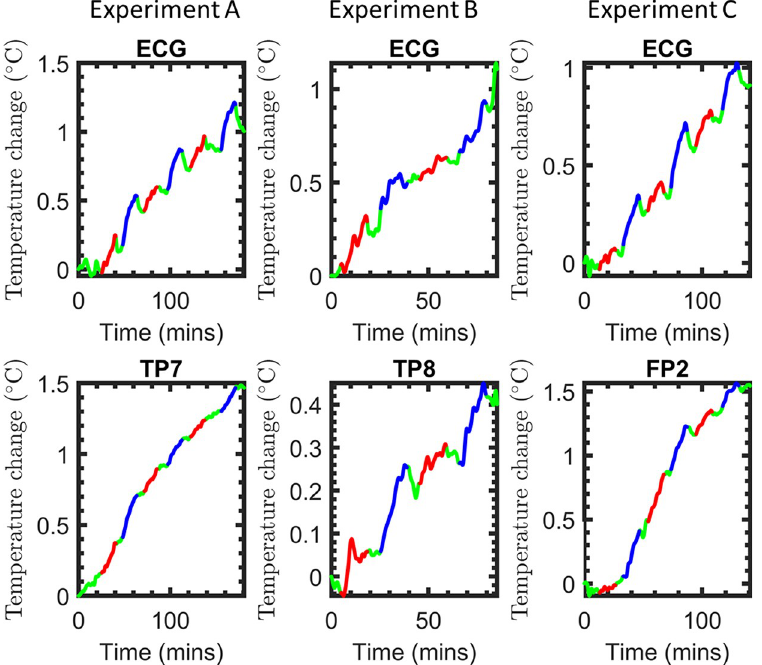
Fig 2. Temperature measurements in the watermelon “phantom”. The total course of consecutive measurements during the different conditions are color coded for the MB sequence (red), the SB sequence (blue), and rest periods of no scanning (green). The ECG electrode, which has the longest lead and highest potential of heating, was included in all three experiments A through C. Experiments A, B, and C additionally measured temperature at TP7, TP8, and FP2,